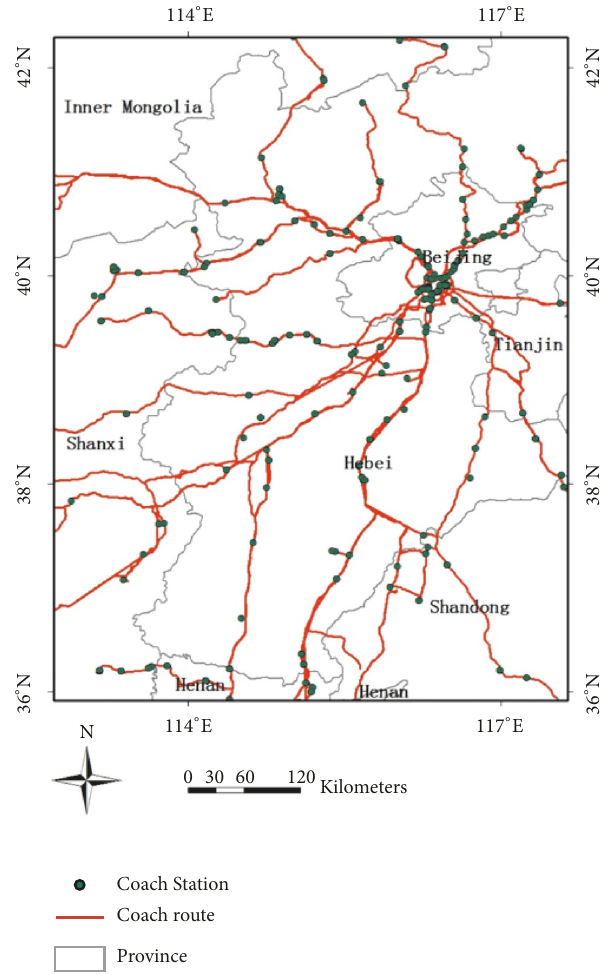
Figure 9: Coach station and route extraction results for the entire